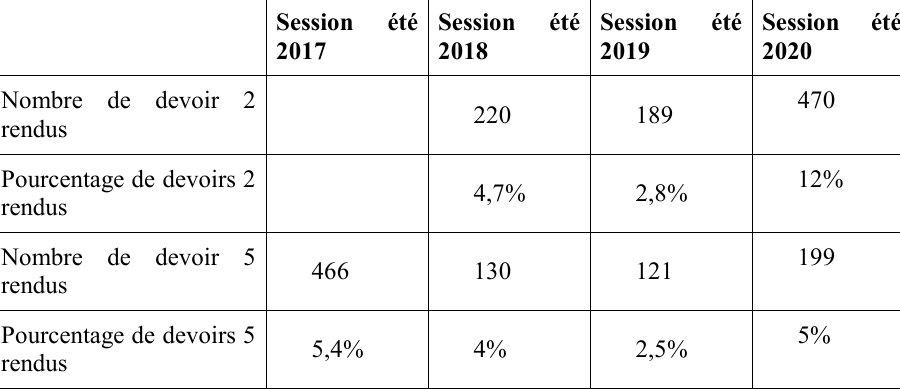
Tableau 7. Pourcentages de validation des QCM selon les sessions.